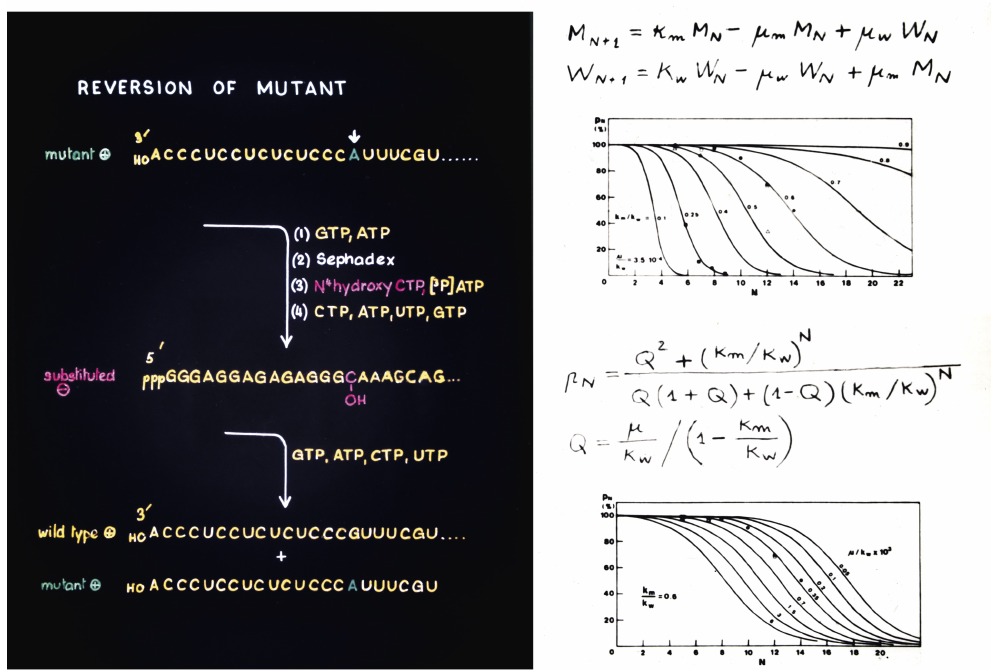
Figure 5. Origins and implications of the quasispecies concept. Images of the work in Charles Weissmann’s laboratory in Zürich in the 1970s. ( Left ): a slide drawn by Weissmann outlining a reversion experiment by site-directed mutagenesis [33]; it is interesting that the N4-hydroxy-CTP used as mutagenic nucleotide is the active component of molnupiravir, presently used as lethal mutagen for SARS-CoV-2. ( Right ): a page of the notebook of Domingo with the experimental data and mathematical predictions of competition between the wild type Q β phage and the infectious extracistronic mutant (top of page), and reversion of the mutant upon multiplication in E. coli (bottom of page) [31,32]; explained also in reference